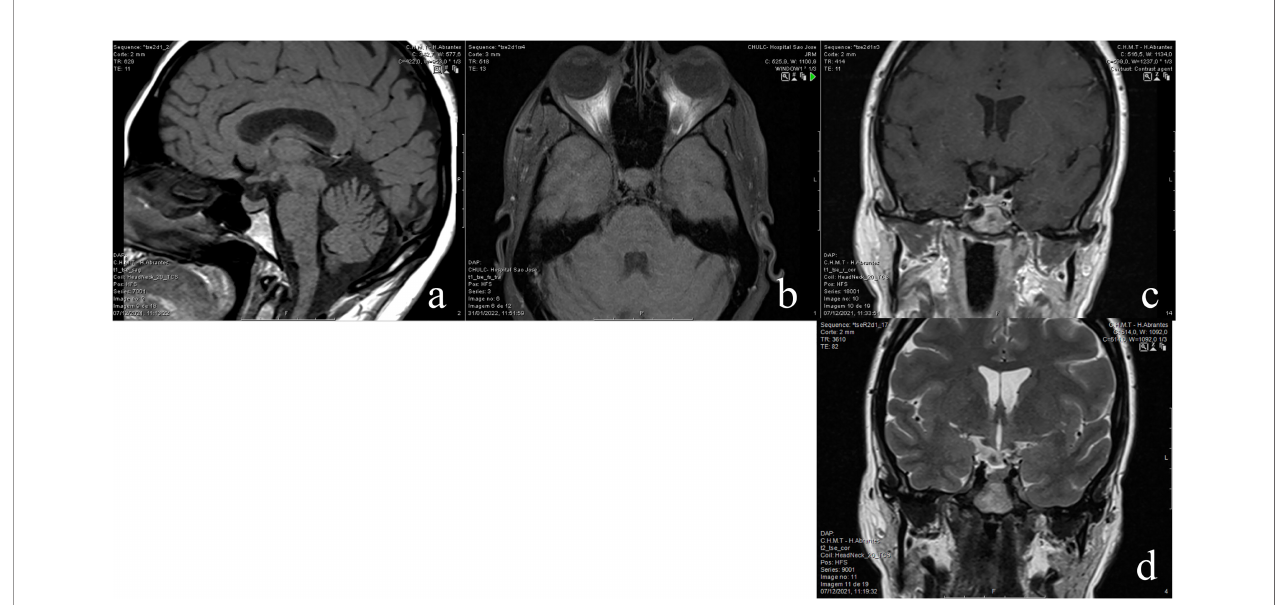
FIGURE 2 | (A) sagital T1 showing a normal anterior pituitary gland and absent posterior pituitary hyperintensity; (B) axial T1 fat-sat con fi rms absent posterior pituitary hyperintensity; (C) - coronal T1 post gadolinium depicts the normal shape and height of the enhancing anterior pituitary gland and pituitary stem; (D) - coronal T2 depicts the normal hypothalamic